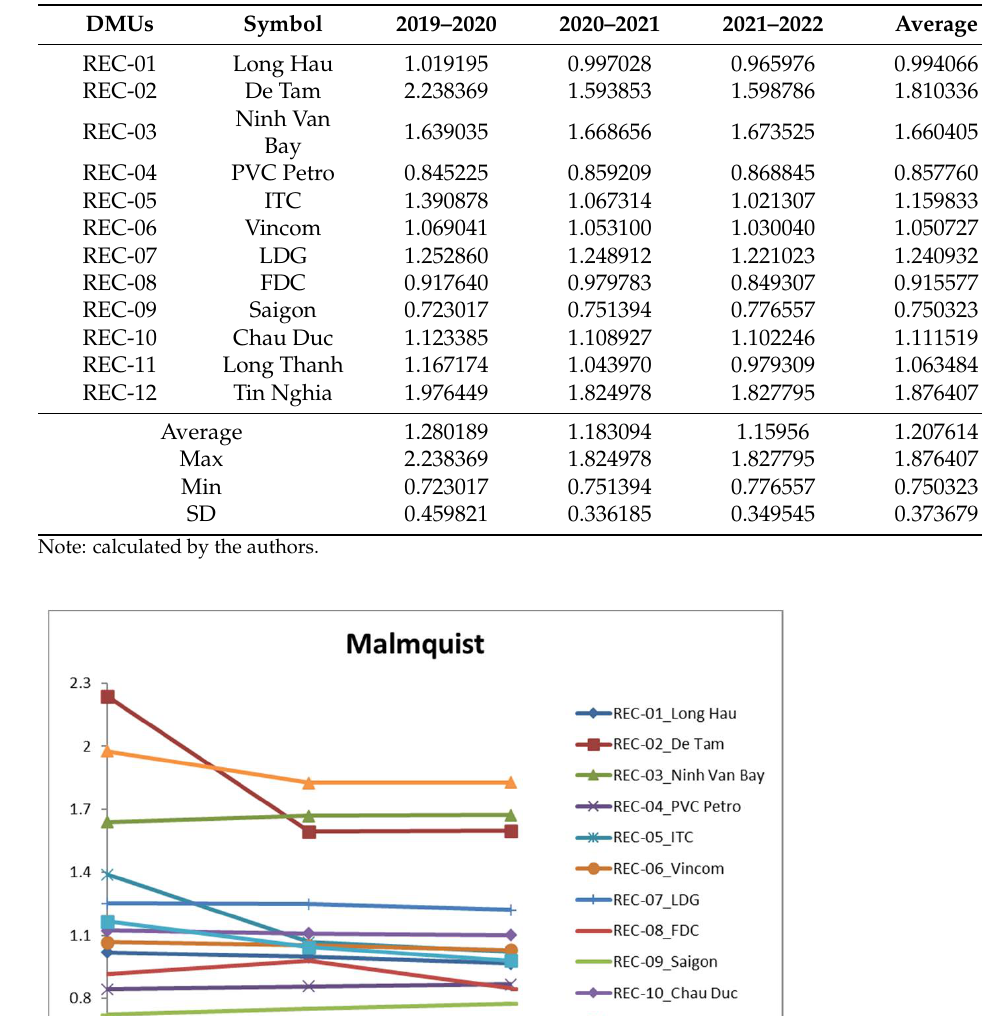
Table 12. Malmquist productivity index (2019–2022).